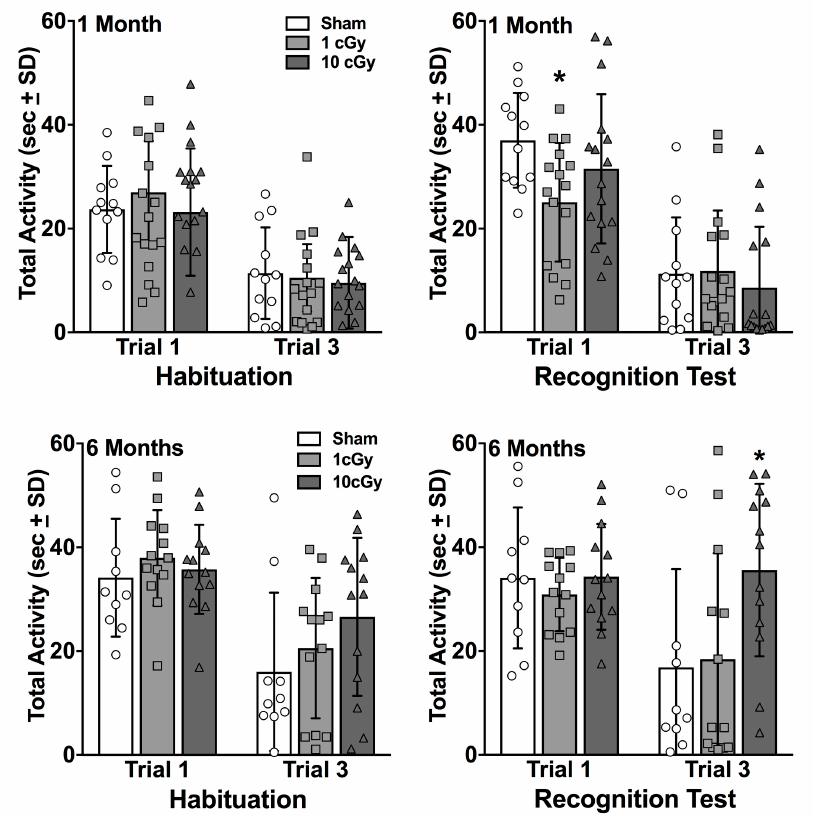
Figure 3. Mean total seconds of exploration on Trials 1 and 3 for Habituation and the Recognition Test at one month (top panels; n = 12–16) and six months (bottom panels; n = 10–13) following exposure. No di ff erences were found among the groups during Habituation at either time point. At one month following exposure, 1 cGy rats had significantly less exploration on Trial 1 of the Recognition Test compared to sham control rats (* p ≤ 0.05). At six months, the 10 cGy rats had significantly greater exploration on Trial 3 of the Recognition Test compared to both sham controls and 1 cGy exposed rats (* p ≤ 0.05). Bars represent group averages and symbols represent individual